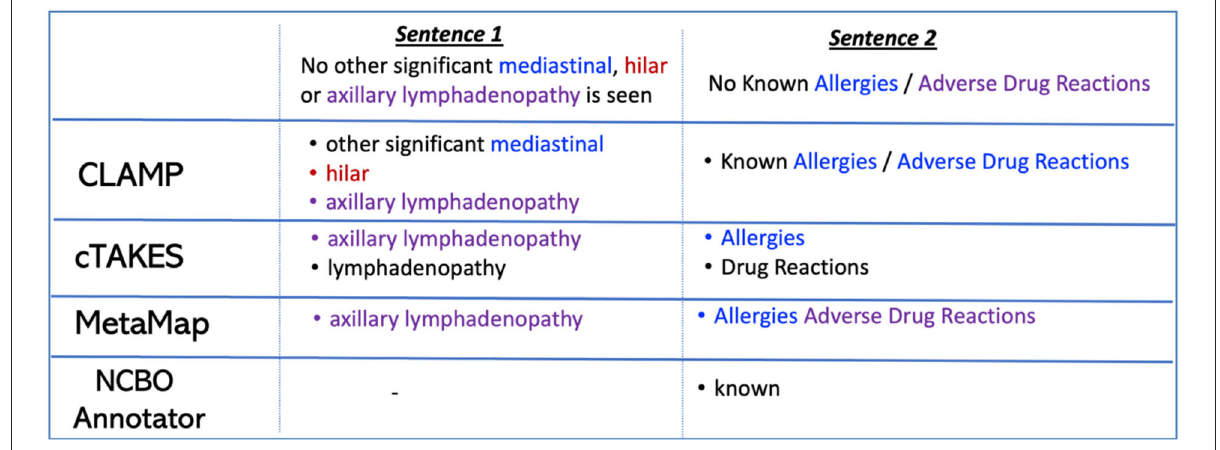
their training processes and the different annotation process of clinical concepts on the two datasets. For instance, there are concepts composed of determiners in the i2b2